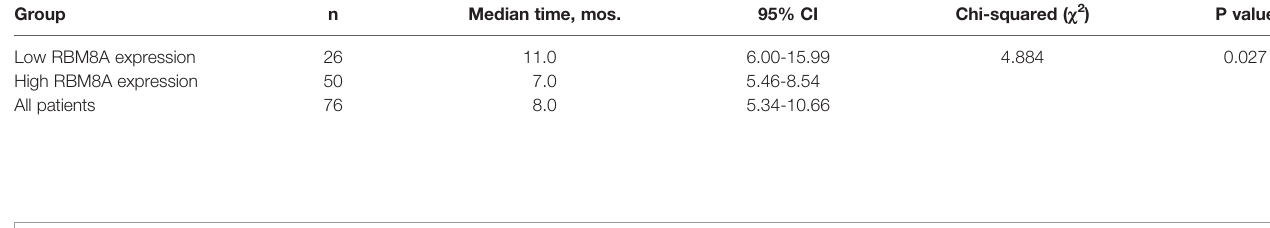
TABLE 2 | Overall survival time of patients strati fi ed by RBM8A expression level. Group n Median time,